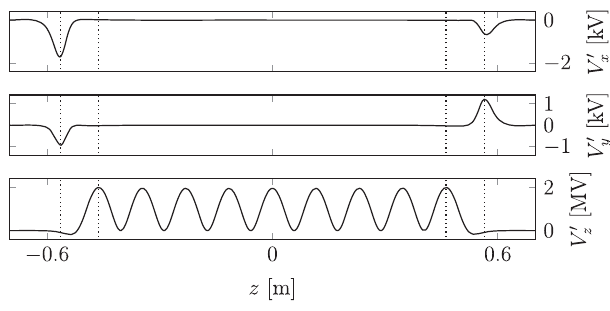
FIG. 6. Horizontal (top), vertical (mid), and longitudinal (bottom) voltage as experienced by an ultrarelativistic charged particle which traverses the cavity on